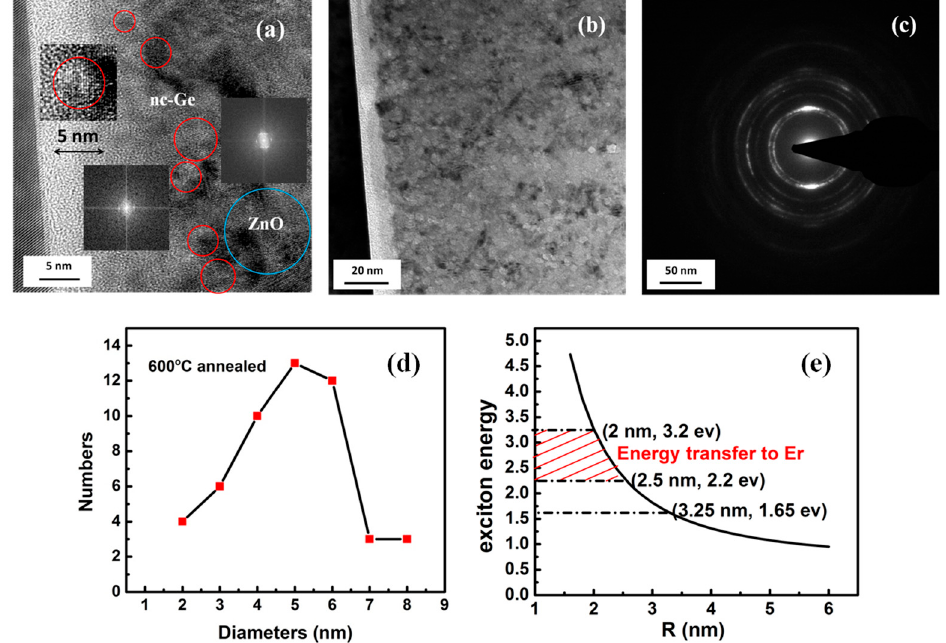
Figure 3. ( a , b ) High resolution transmission electron microscope (HRTEM) cross-section images of different proportional scale for the 600 °C annealed Ge:Er:ZnO film; ( c ) A diffraction pattern from the film; ( d ) Size distribution of nc-Ge in 600 °C annealed Ge:Er:ZnO film; ( e ) The relation of emission energy versus radius R of nc-Ge.